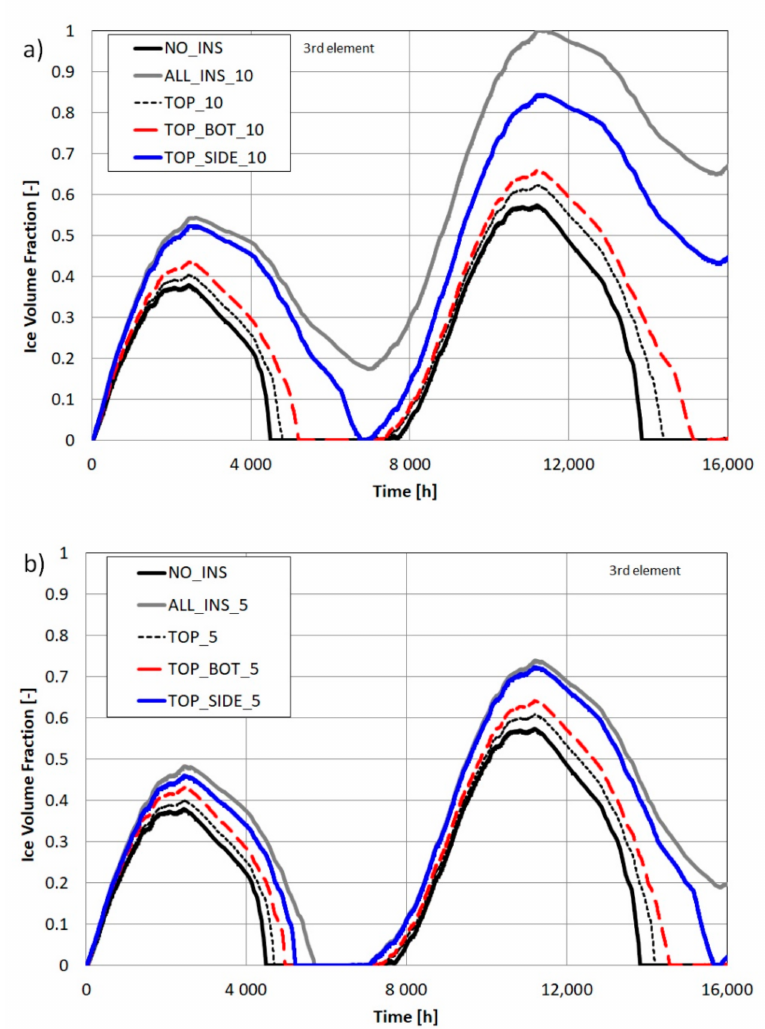
Figure 9. Ice volume fraction of the 3rd element of the IT: ( a ) 10-cm cases; ( b ) 5-cm